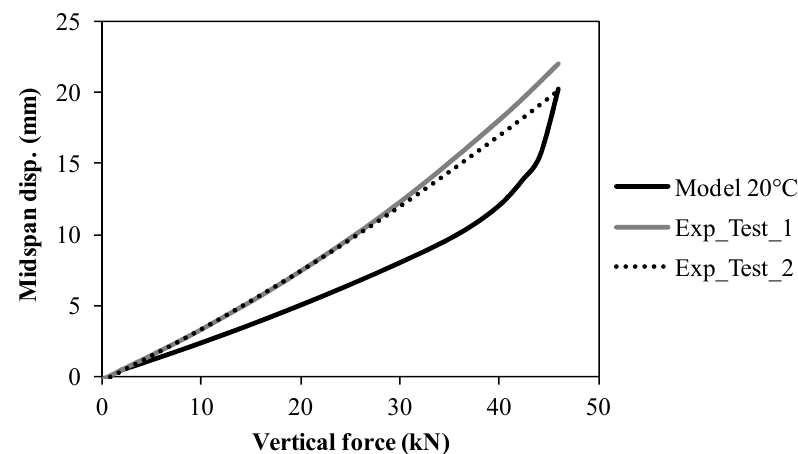
Figure 6. Modelling results for the capacity tests at 20 °C.